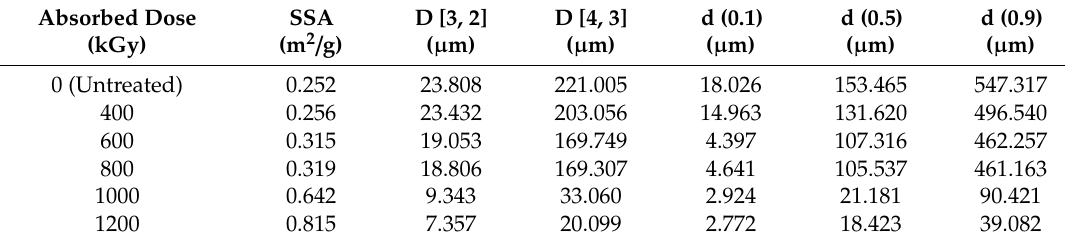
Table 2. E ff ect of absorbed doses on particle size and SAA of Miscanthus